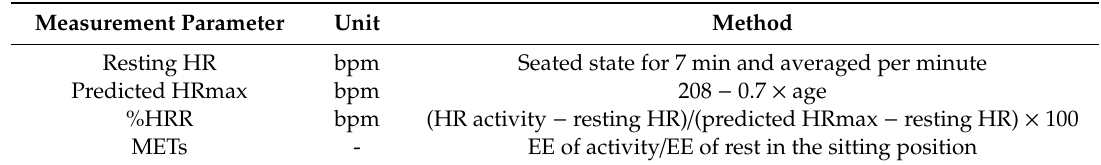
Table 1. Measurement parameters and measurement